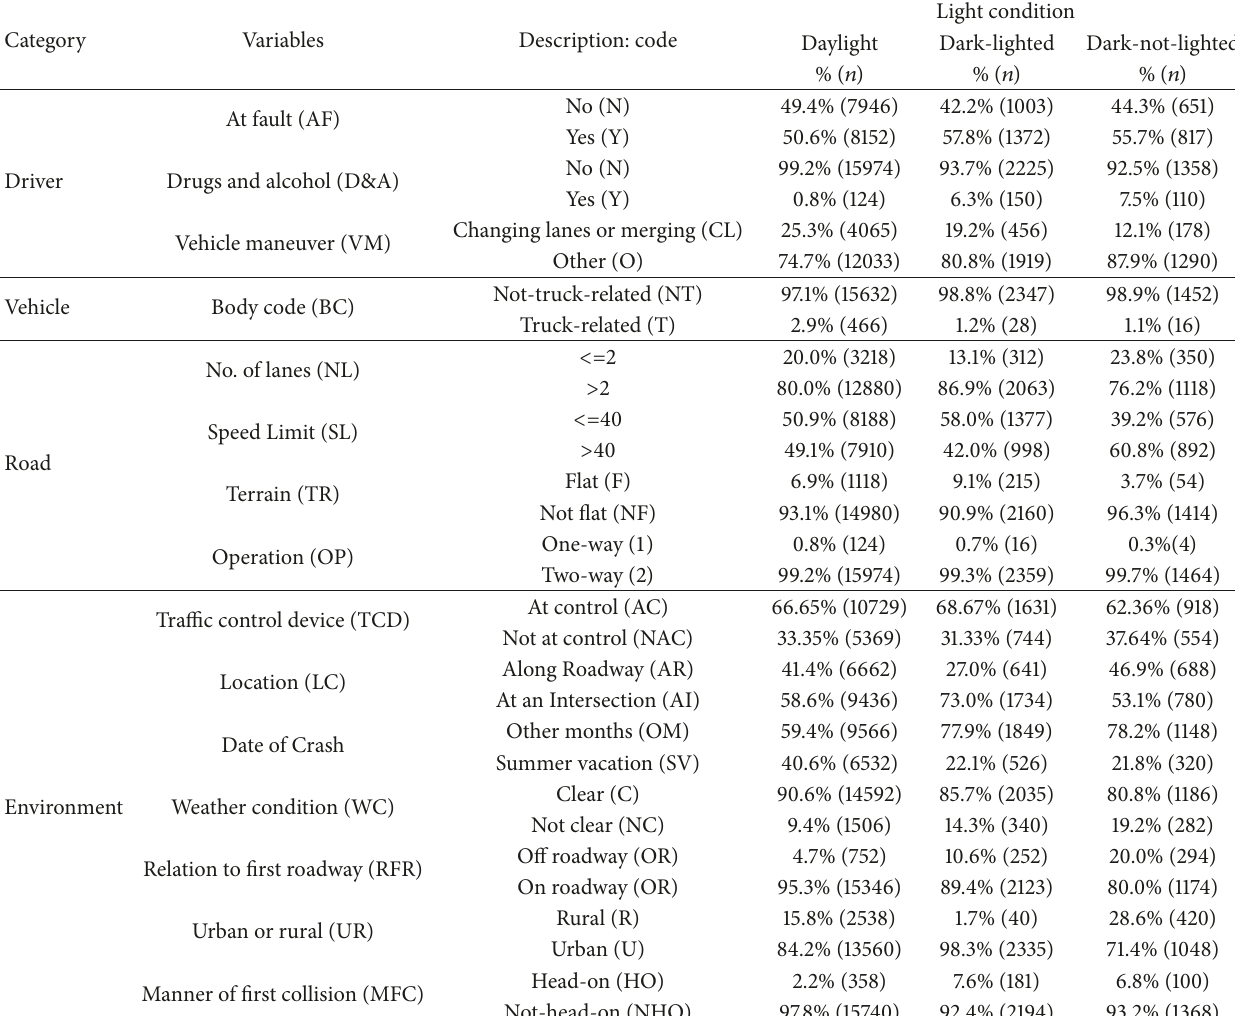
Table 1: Description of variables.